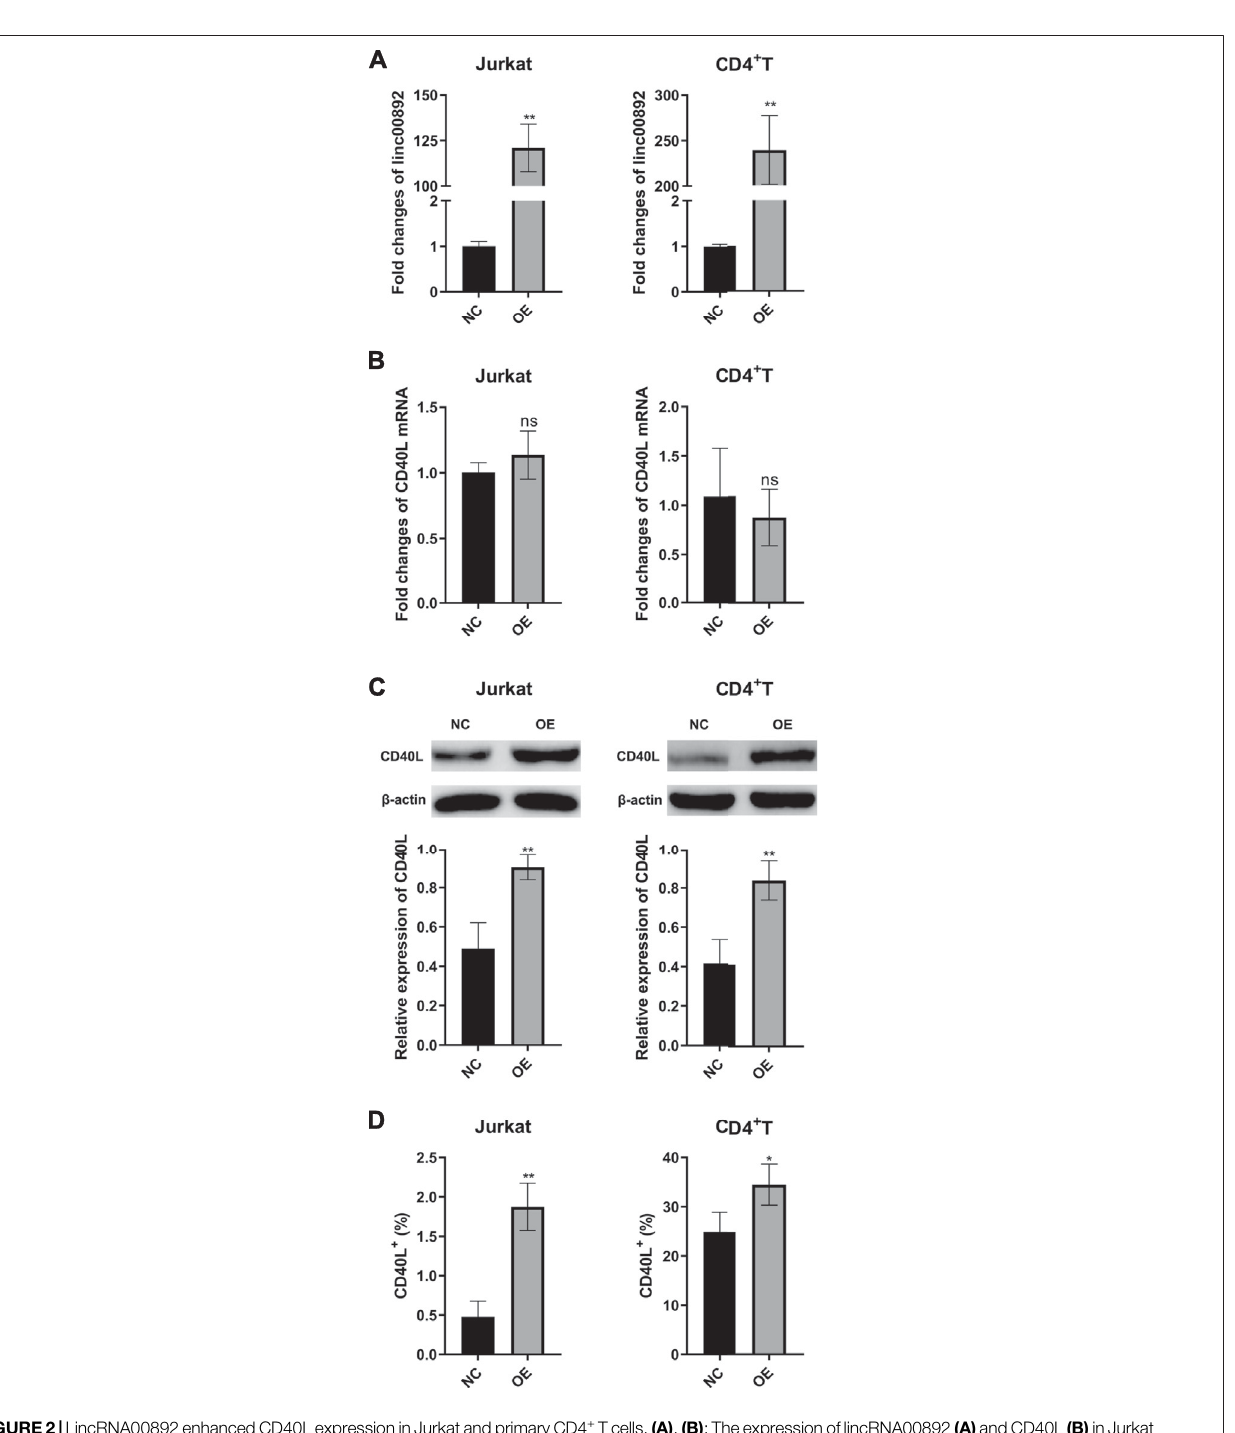
Frontiers in Pharmacology |